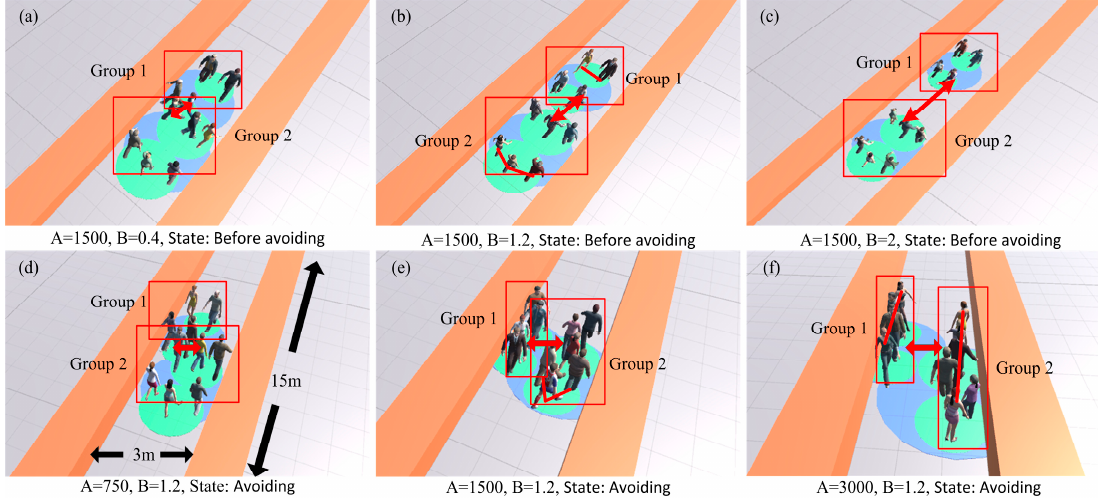
Figure 8. Comparisons of groups that avoid space with different parameter B ( a – c ) and groups avoidance intensity with different parameter A ( d – f ).